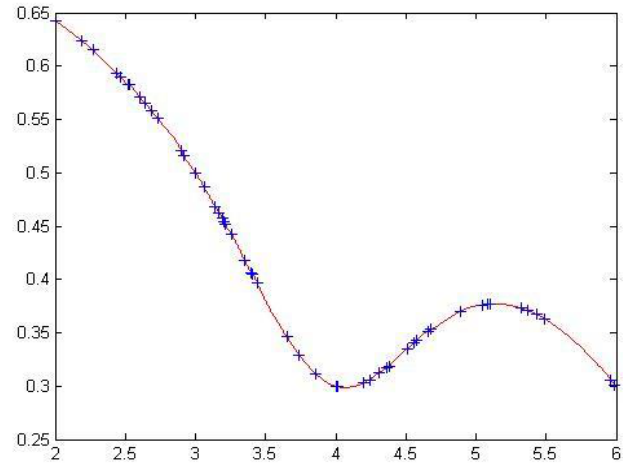
Figure 2. The Cubic Spline approximate of 𝐷𝑀𝑈